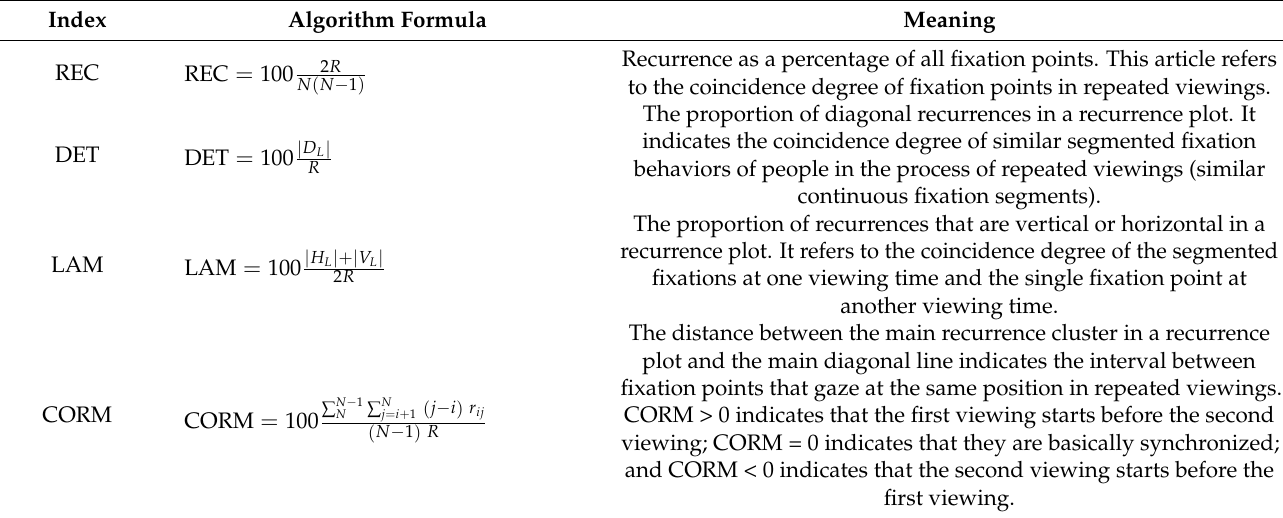
Table 1. CRA indexes and meanings.